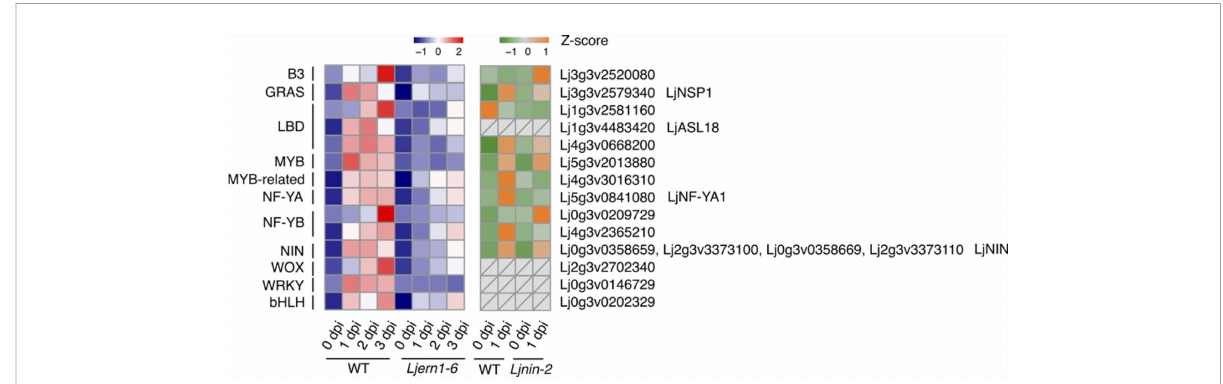
FIGURE 6 Transcript response of transcription factor genes in WT and mutants Heatmap showing expression patterns of differentially expressed transcription factor genes in WT (MG-20) and Ljern1-6 mutants (left grid) and WT (Gifu B-129) and Ljnin-2 mutants (right